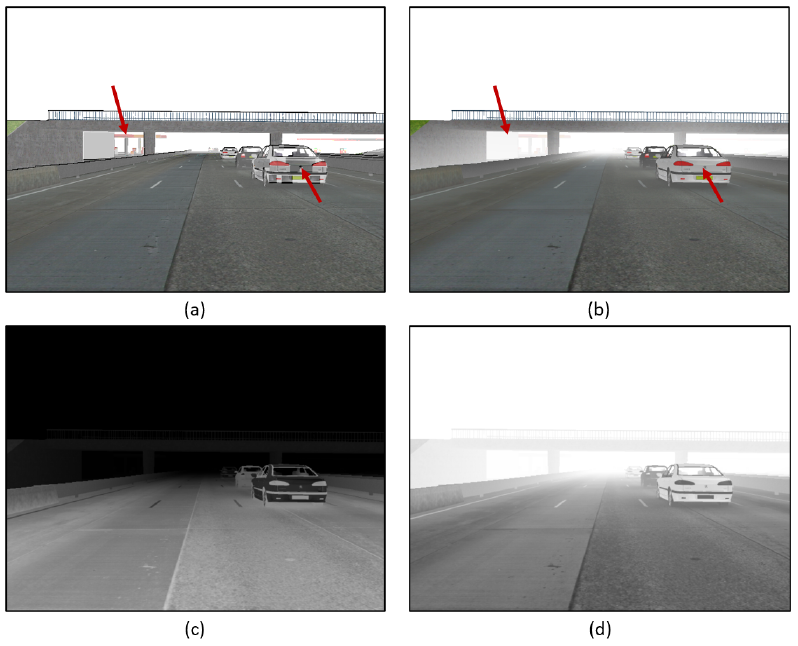
Figure 10. FRIDA images: ( a ) restored image; SSIM = 0.89 and PSNR = 17.9; ( b ) restored image; SSIM = 0.89, PSNR = 17.7, ( c ) weight map focusing on the bottom part of the input foggy image, and ( d ) weight map focusing on the foggy part of the input foggy image.